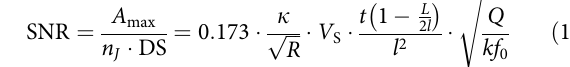
fluctuations A max to the NTR voltage noise n J , scaled by the deflection sensitivity DS: